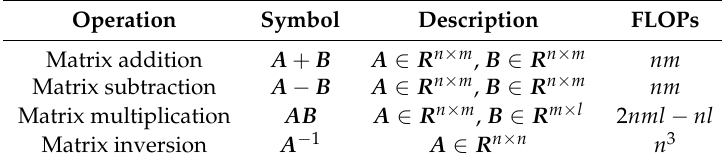
Table 5. Floating point operations (FLOPs) of basic algebraic operations.